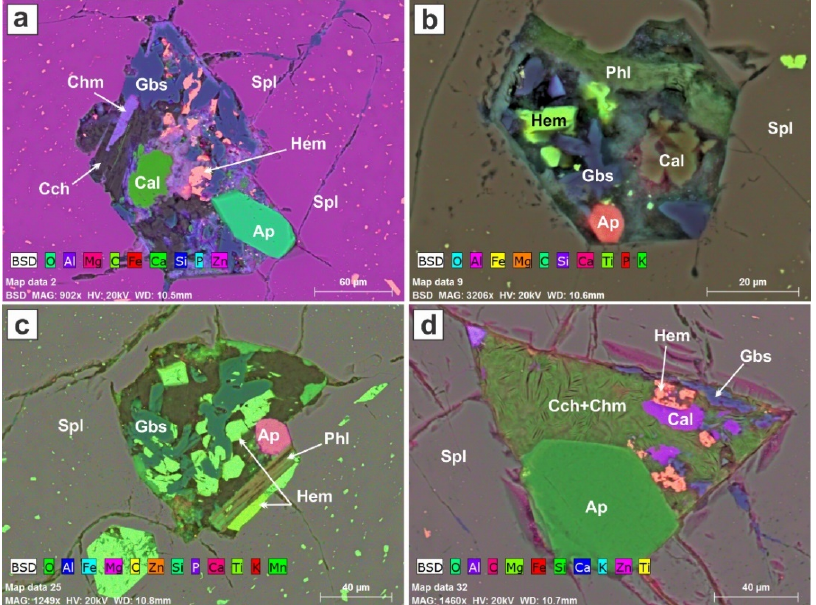
Figure 10. False-color EDS element-distribution maps of polymineralic micro-inclusions found in the two polished halves of the large single crystal of spinel that show an extensive development of secondary minerals.